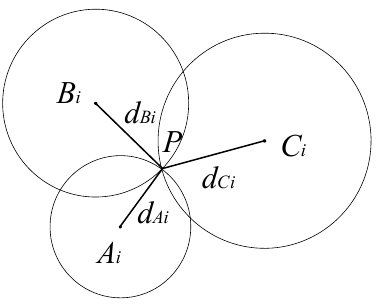
Figure 2. The diagram of trilateration positioning calculation. According to the distances formula between the unknown nodes and anchor nodes.